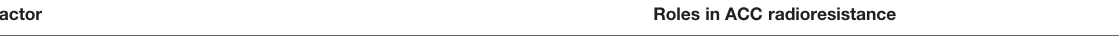
TABLE 2 | Notable molecular actors of ACC stemness and radioresistance properties. Molecular actor Roles in ACC radioresistance